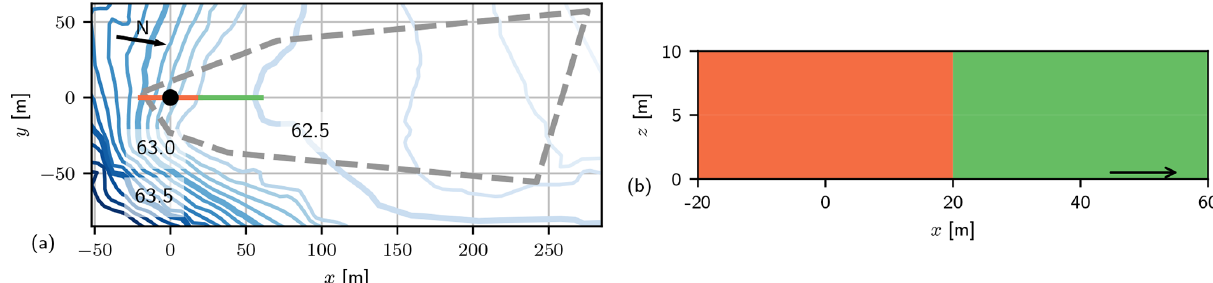
Figure 1. (a) Potentiometric surface map of head measurements according to Boggs et al. (1990). The orange–green line indicates the location of the cross section displayed in (b) : concept (Module A) for large conductivity structure with deterministic zones of low (orange) and high (green) conductivity. The arrow indicates the flow direction. The location of the interface between structures corresponds to a change in the hydraulic head pattern at x =